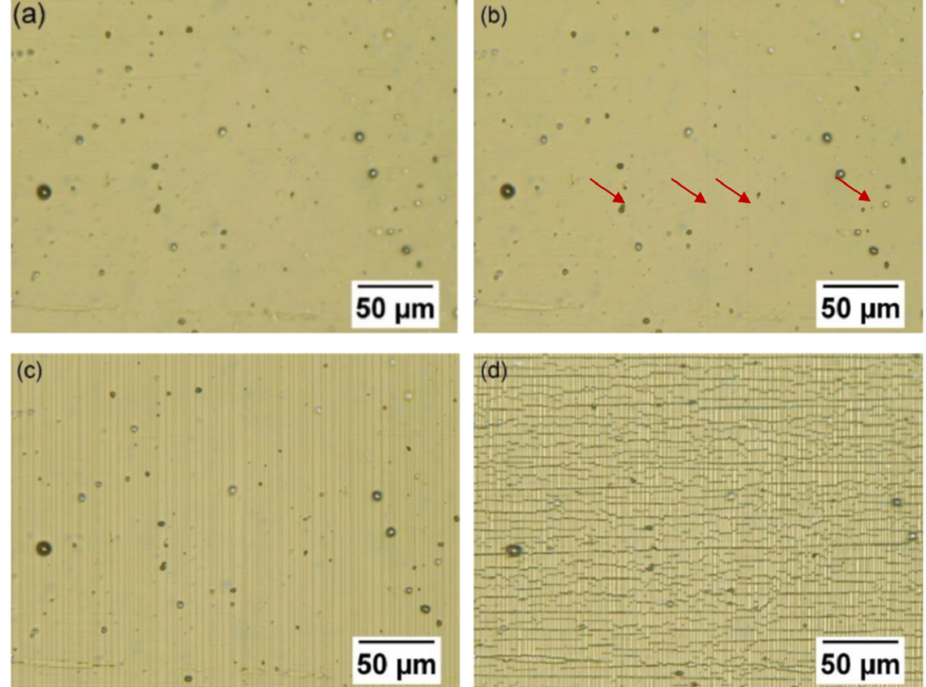
Figure 3. Optical microscope images of the fragmentation process of the 46 nm thick Y 2 O 3 film grown directly on the polyimide substrate. The strain was applied horizontally in the field of view of the image. ( a ) Unstrained Y 2 O 3 specimen. ( b ) At 0.7% tensile strain, the first cracks were observed. ( c ) At 4.6% tensile strain. ( d ) At 20.3% tensile strain, many transverse buckles were